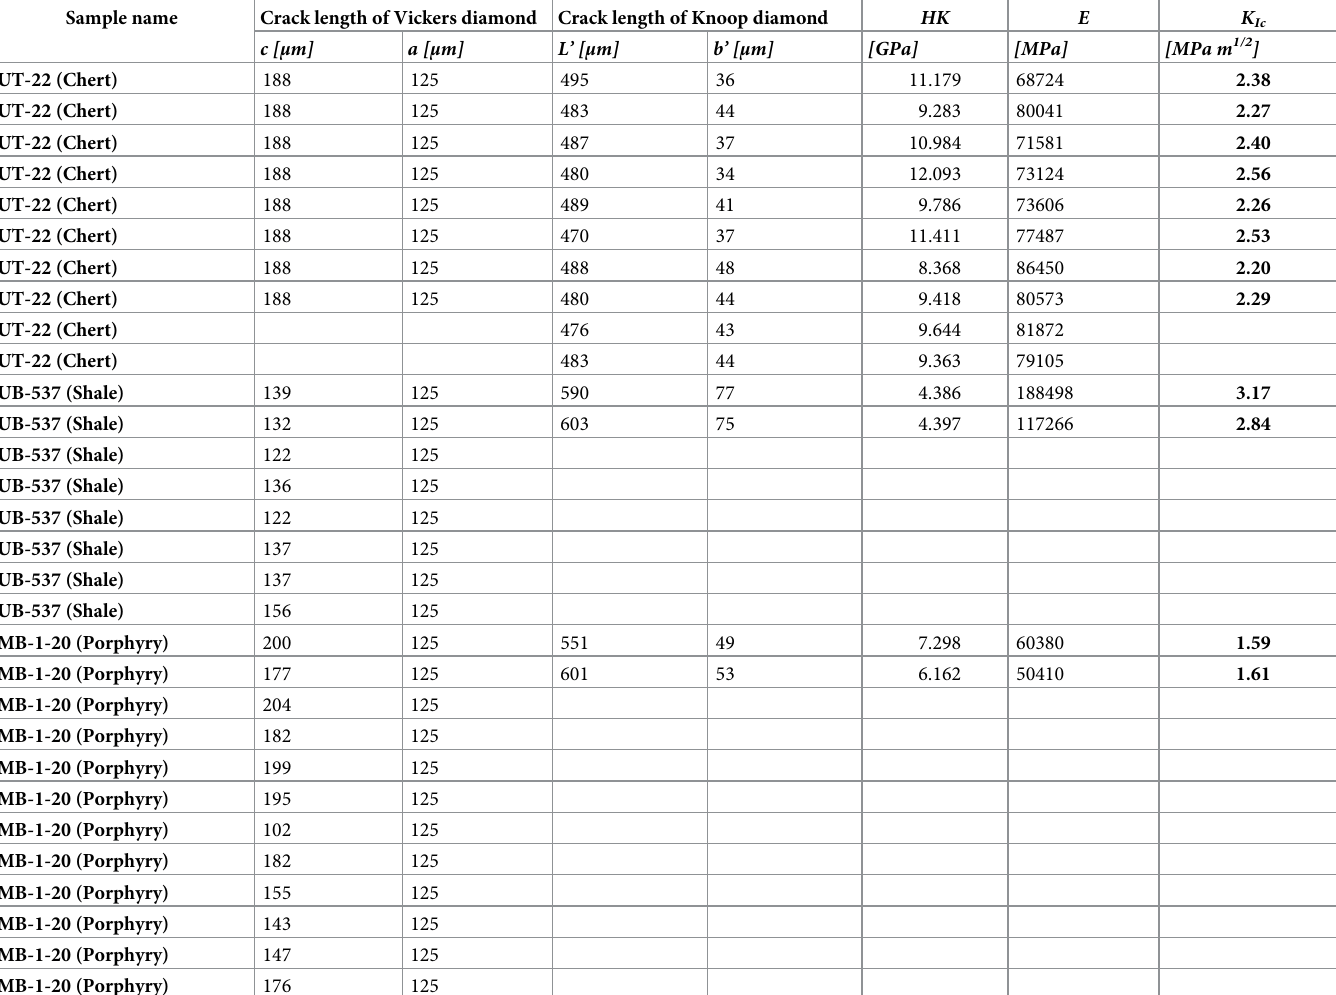
Table 3. The values of hardness (HK), elastic modulus (E), fracture resistance (KIc), crack lengths of Vickers and Knoops diamonds as calculated from the Vickers and Knoop